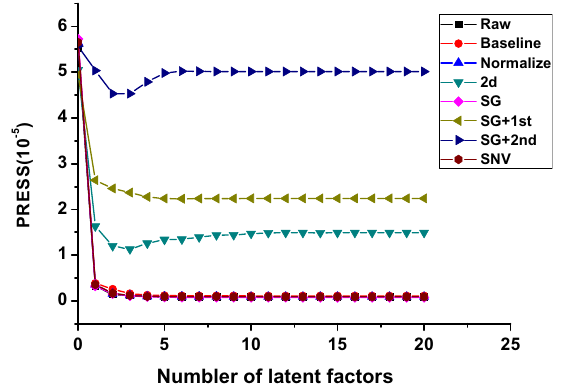
Fig. 3. PRESS plot of NIR by di®erent pretreatments.